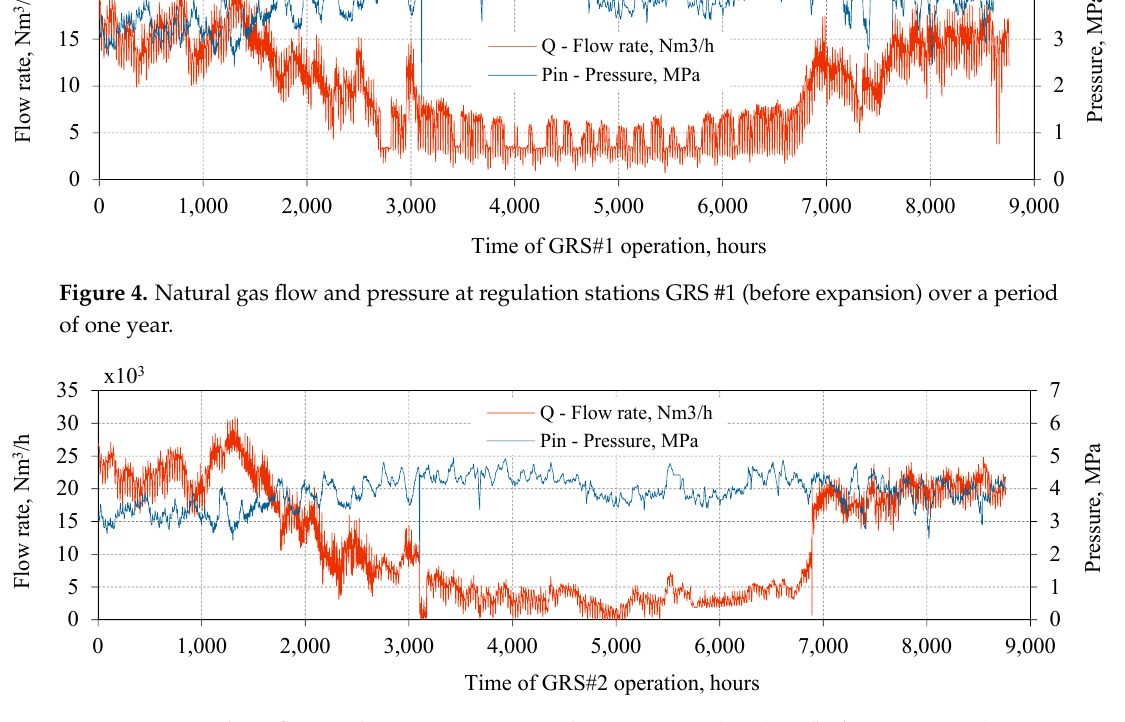
Figure 5. Natural gas flow and pressure at gas regulation stations (GRS) #2 (before expansion) over a period of one year.